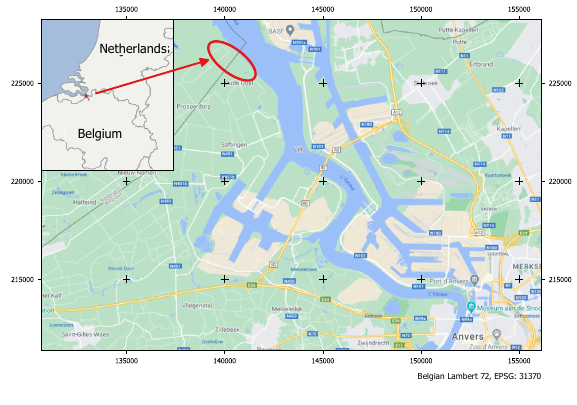
Figure 1. Location of the study